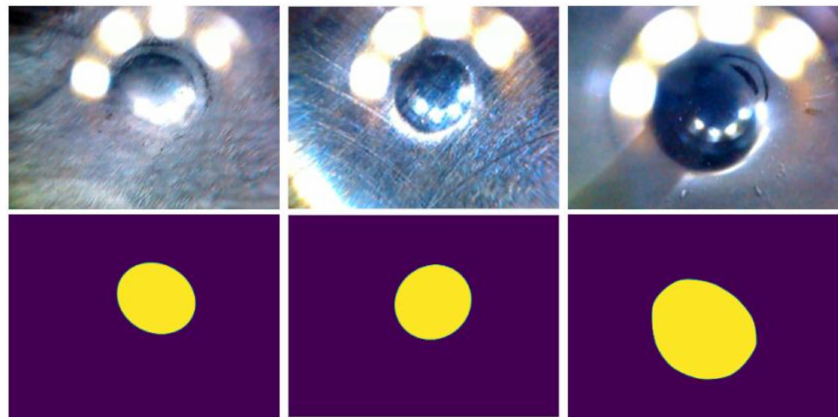
Figure 2. ( Top ) Sample images with di ff erent surface coatings and bearing area sizes. ( Bottom ) Corresponding bearing area